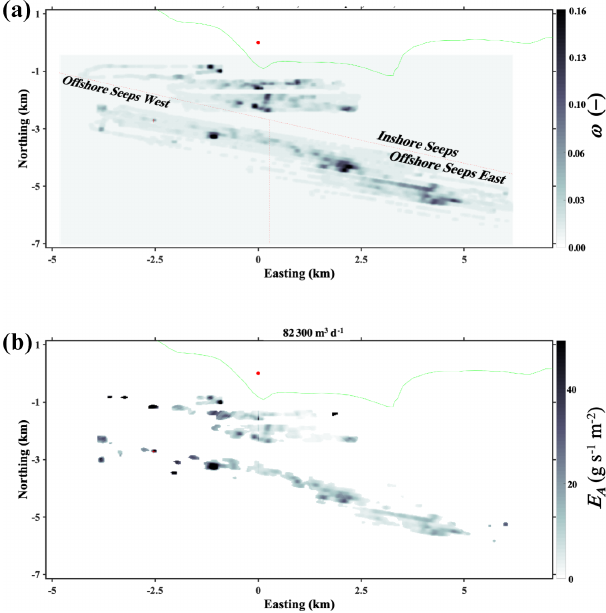
Figure 7. (a) Sonar return, ω , gridded at 22m resolution. (b) Atmo- spheric emissions, E A . The West Campus Station (red dot) is at the coordinate system origin. The green line is the